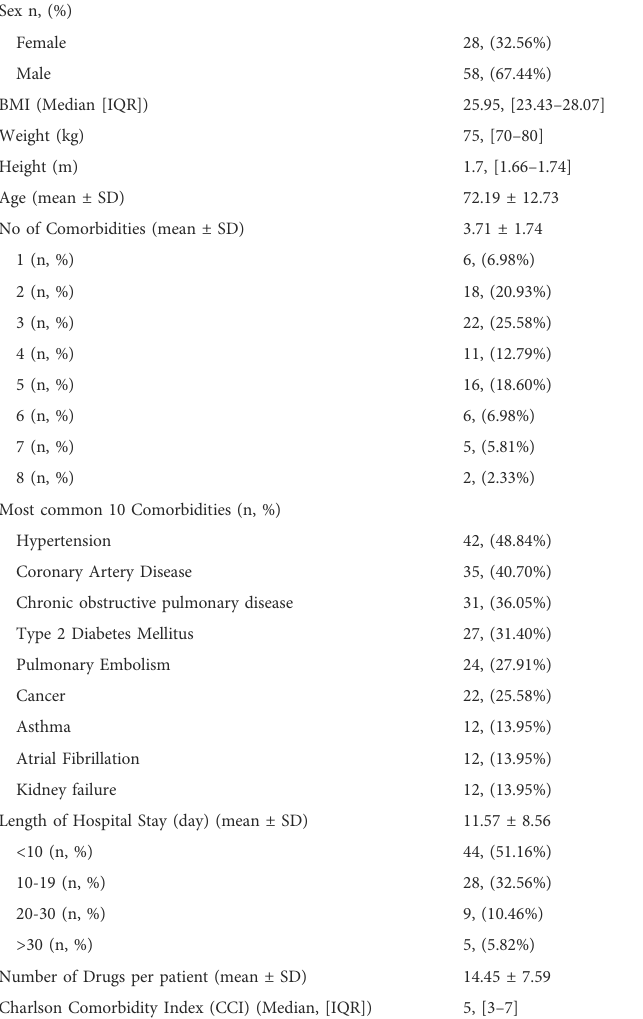
Discussion Chest diseases can occur due to different reasons. In particular, the presence of diseases increases mortality and morbidity increase the need for health care services. The most common DRPs were mainly drug (C1, 49.37%) or dose selection (C3, 40.51%). The intervention made by CPs for DRPs were mainly at prescriber level (I1, 88.16%) and the acceptance rate of the intervention was (A1, 84.21%) (table 3 and 4). Similar to literature patients with higher number of comorbidities, polypharmacy, increased Charlson Comorbidity Index (CCI) scores, previous history of frequent hospital admission and patient with infectious diseases were more prone to DRPs and pDDIs (15 – 17).